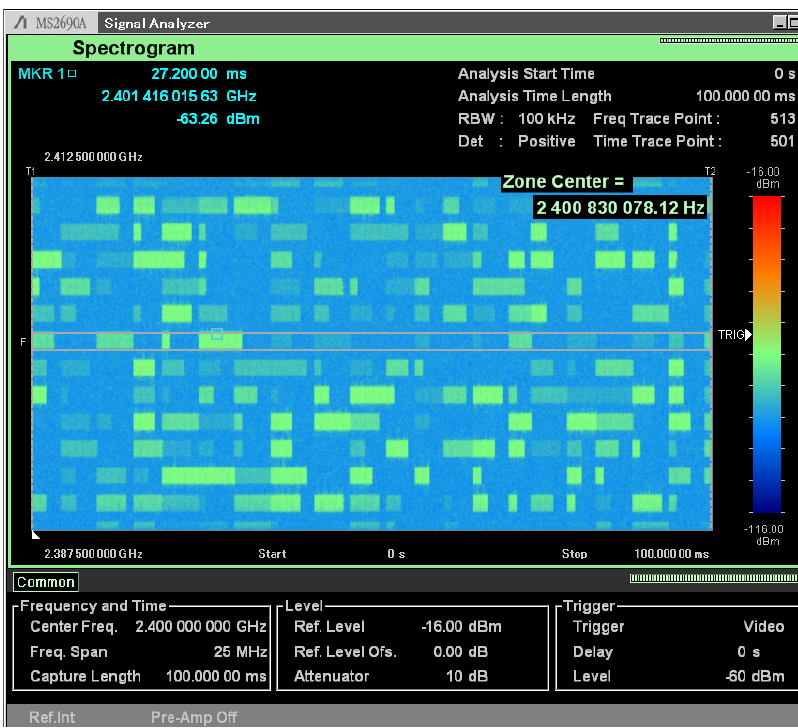
Figure 19. Spectrogram of 12 vPHYs with discontinuous transmissions and independent frequency gains at a center frequency of 2.4